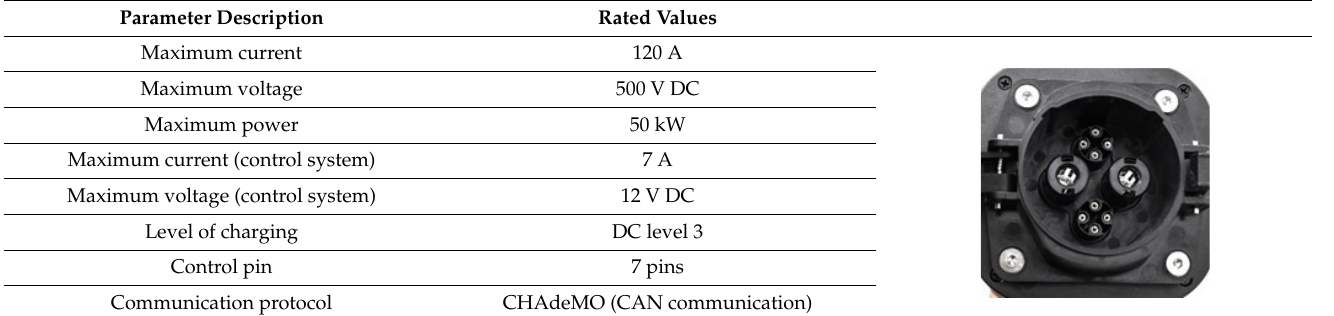
Table 3. CHAdeMO connector characteristics [31].